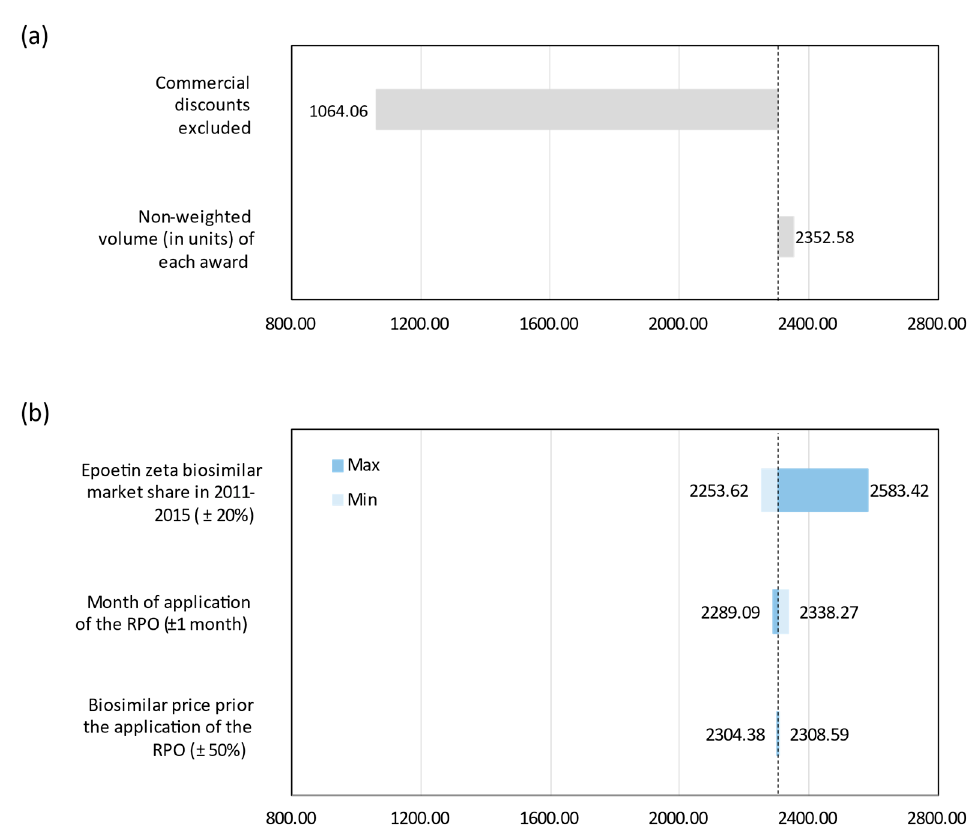
Figure 3. Results of the scenario and sensitivity analyses. ( a ) Scenario analysis. ( b ) One-way sensitivity analysis. The dotted line represents the base case value.